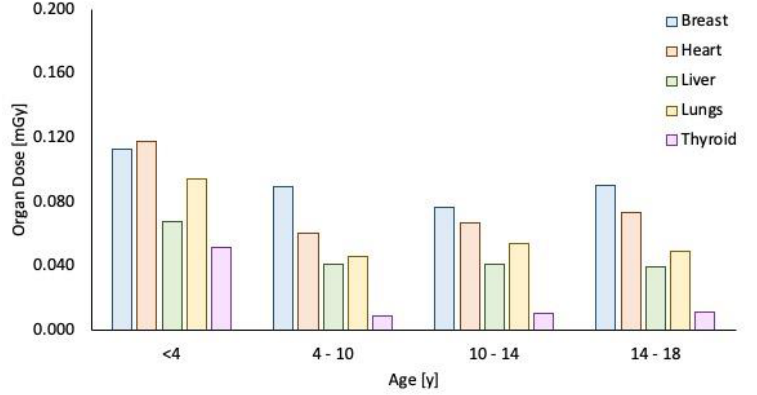
Figure 5. Dose area product trend from 2016 to 2019 in different patient age groups. In addition, the mean doses to organs fully or partially contained in the field of view (e.g., heart and thyroid, respectively) were significantly reduced (Figure 6).